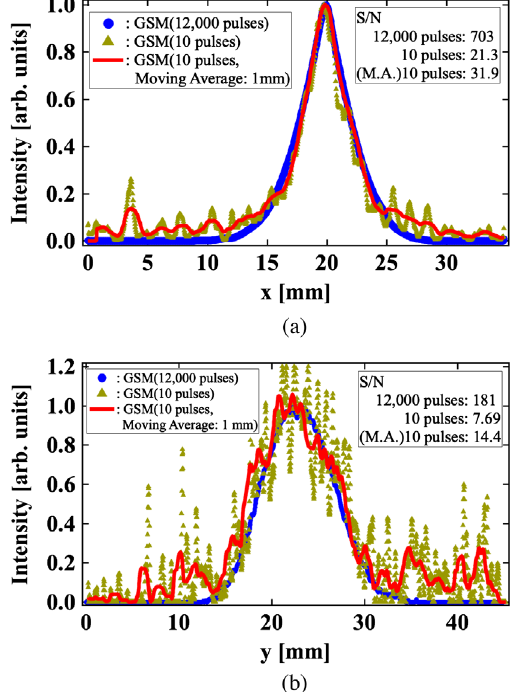
FIG. 17. The beam profiles obtained by the gas sheet monitor (GSM) integrating ten or 12,000 beam pulses: (a) the projected x profiles and (b) the projected y profiles. The y profiles are normalized after subtraction of the base